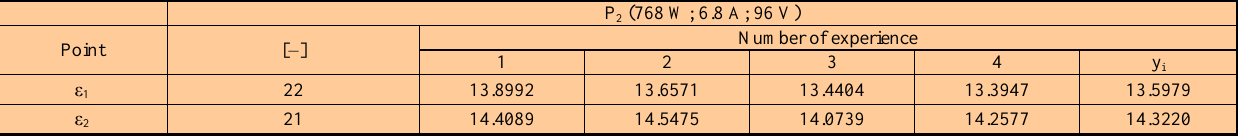
Table 3b. Value (average within one working cycle) of exhaust gas enthalpy h śr for variable values of compression ratio in point P 2